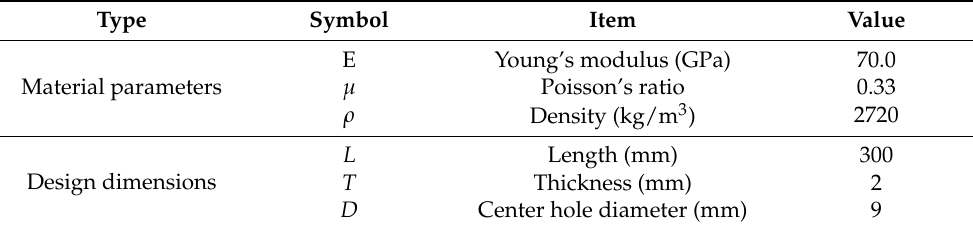
Table 3. Reference material parameters and design dimensions.